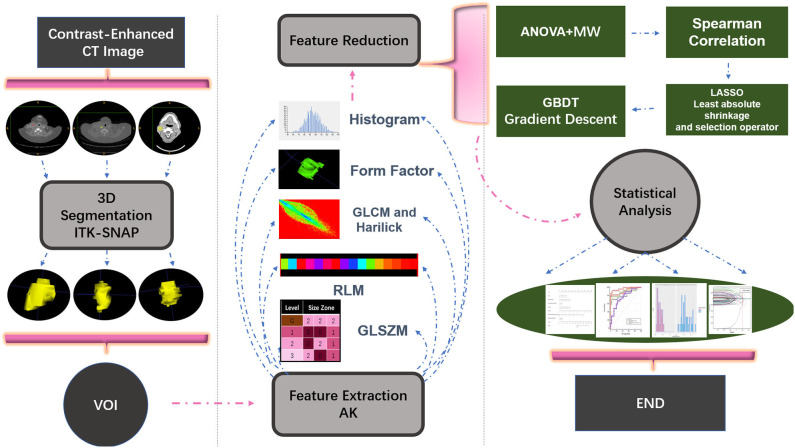
Illustration of the process of data analysis. First, each layer of the lesion was manually segmented and automatically merged into a three-dimensional volume of interest (VOI) in the software. Then, upon extraction of the VOI radiomic features, relevant statistical methods were carried out for feature dimensionality reduction, and finally a statistical analysis on the selected features was performed and a model classifier was established.